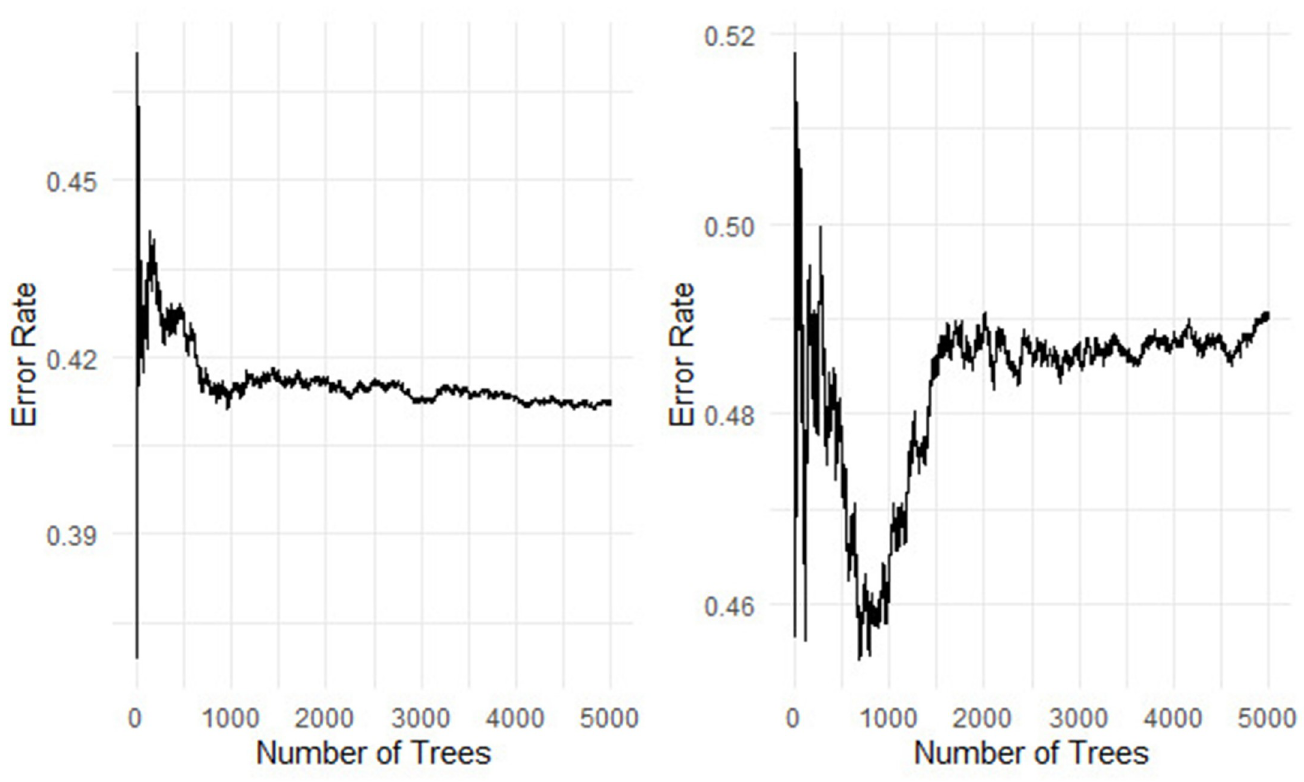
Fig 3. The prediction error rate for the random survival forests of 5000 trees before imputation and the log-rank and log-rank-score in the left and right panel used 80% training dataset.